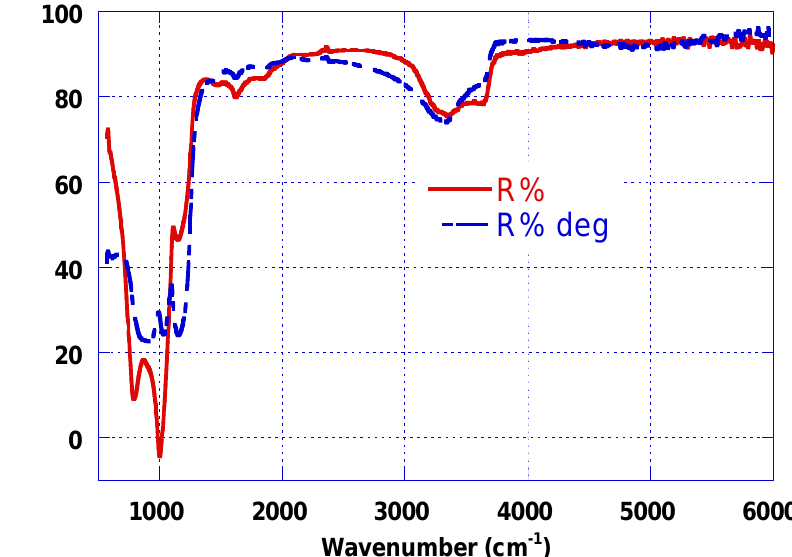
Figure 11. FTIR Reflectance before the field test and after 1 month.